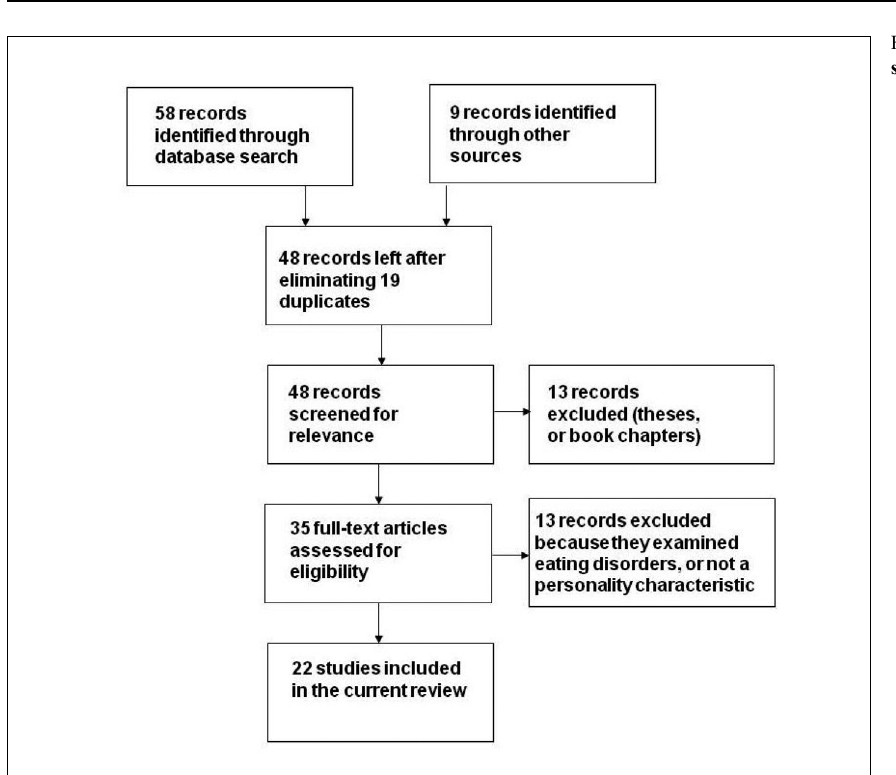
Figure. The process of selecting studies for